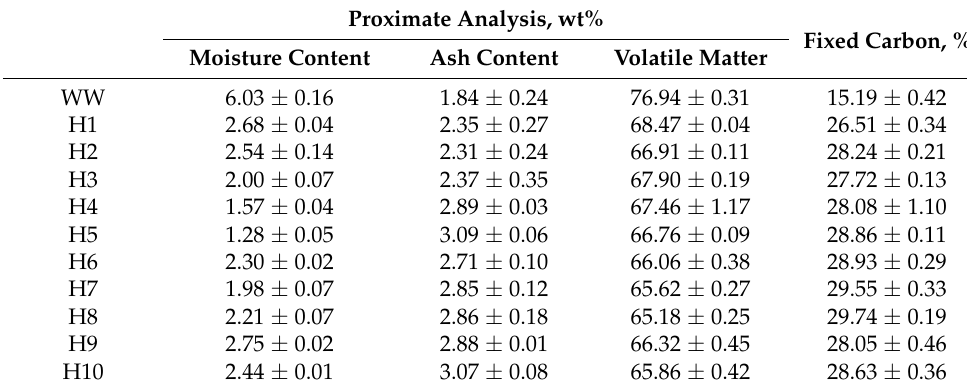
Table 1. Proximate analysis of biomass and hydrochar.